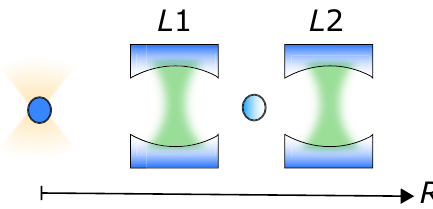
FIG. 5. Corrective sites as Rabi